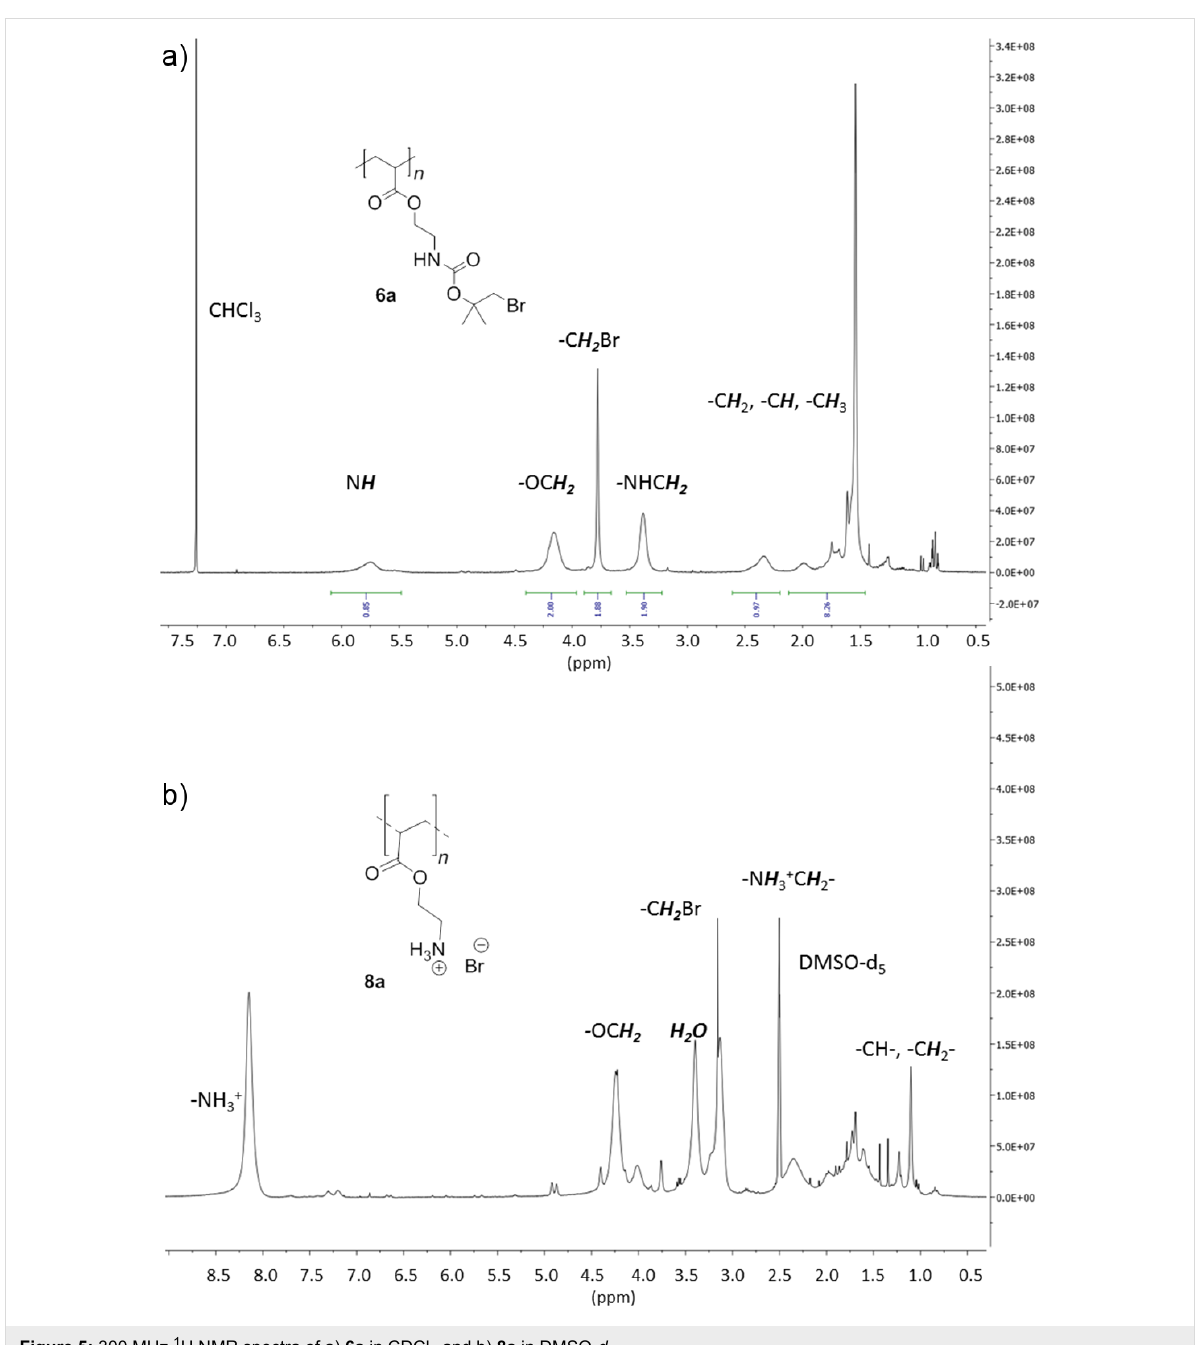
Figure 5: 300 MHz 1 H NMR spectra of a) 6a in CDCl 3 and b) 8a in DMSO- d 6 .